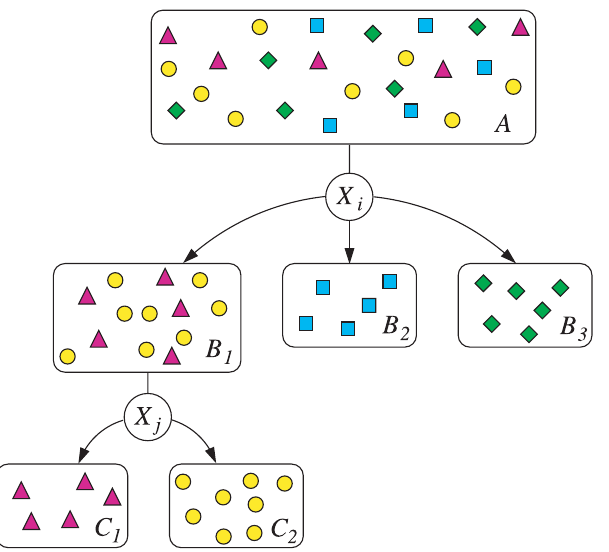
Figure 7. Test creation process for decision trees. Samples from four haplogroups in data set A are passed through locus-specific allele test conditions at each branch of the decision tree. The test for locus X i is chosen so that i =arg max l {IG( A , X l )} and X j so that j =arg max l { IG( B 1 , X l )}.